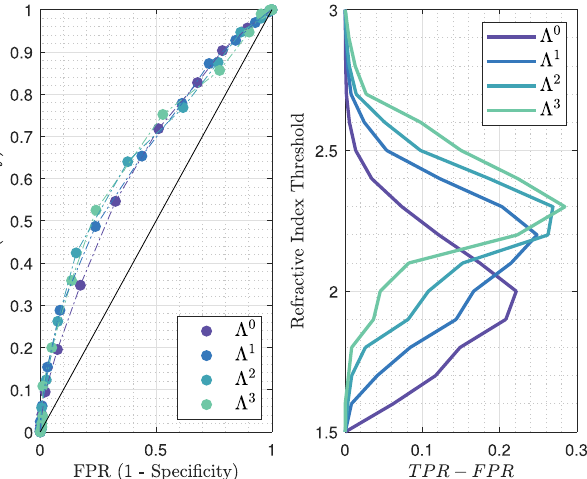
Figure 14. Left: receiver operating characteristic for the different classification methods, at 550-GHz applied to TS#3. The black line stands for TPR = FPR . Right: refractive index threshold as a function of the TPR − FPR measure for the different classifiers.